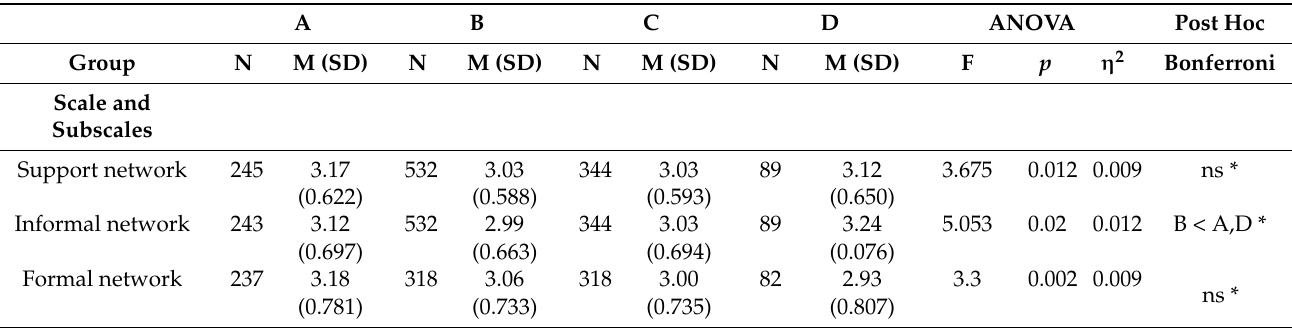
Table 5. Descriptive statistics and analyses of variance for the support network scale and its subscales according to the parents’ employment statuses.